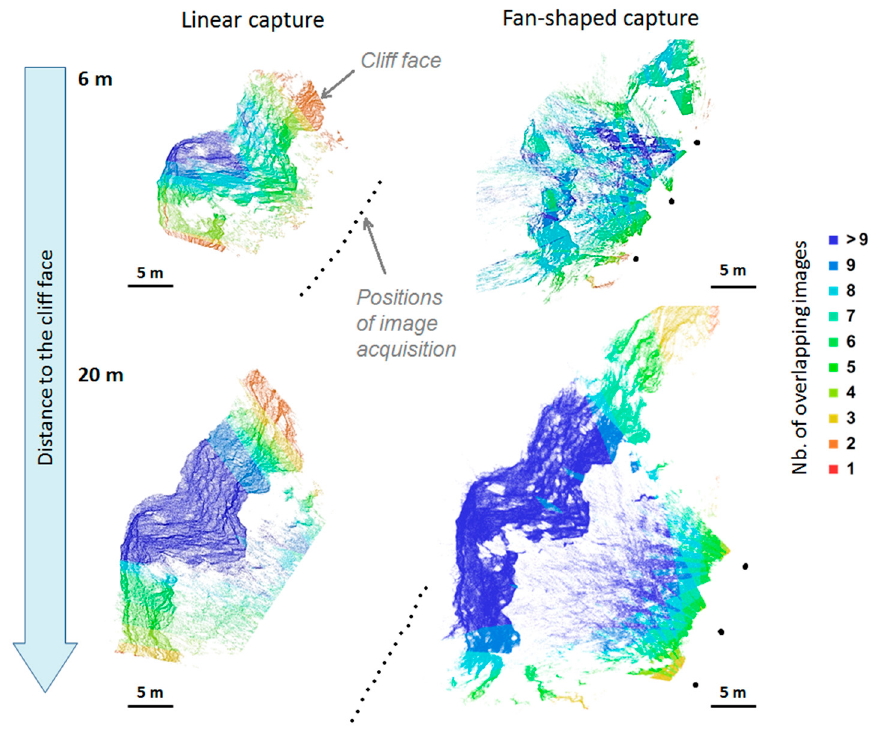
Figure 10. Impact of the survey protocol (capturing mode and distance) on the image overlap.